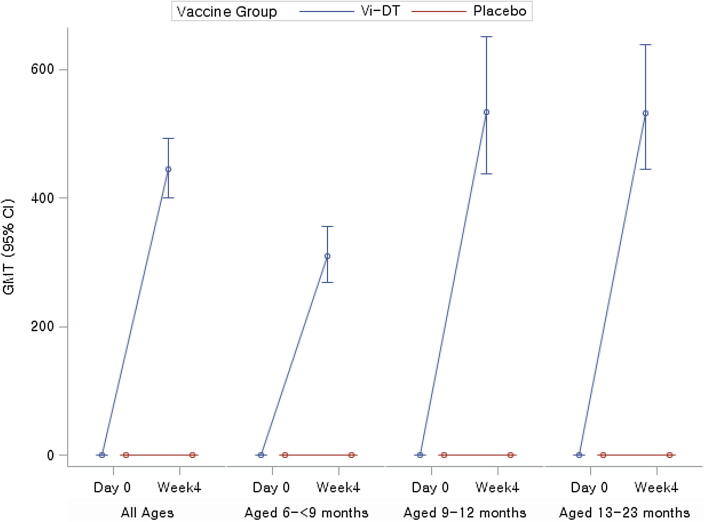
GMT of anti-Vi IgG ELISA response. [Note] Among all participants the difference in GMT comparing Vi-DT to placebo was statistically significant (p < 0.0001).